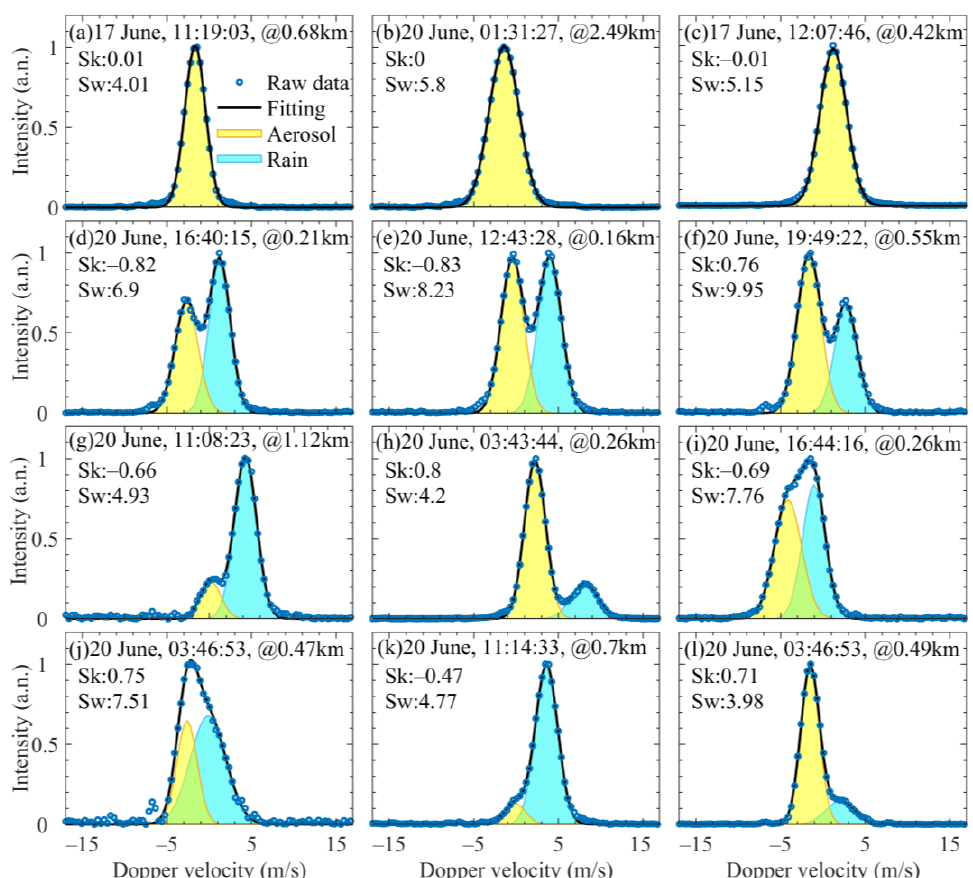
Figure 3. Examples of different types of Doppler spectra. ( a ) General aerosol spectrum; ( b ) cloud spectrum; ( c ) spectrum under strong turbulence; ( d – l ) precipitation spectra and its separation results. Circles stand for the raw data of spectra. Black lines represent fitting results. The yellow shadow and light blue shadow represent separated aerosol and rain components, respectively.